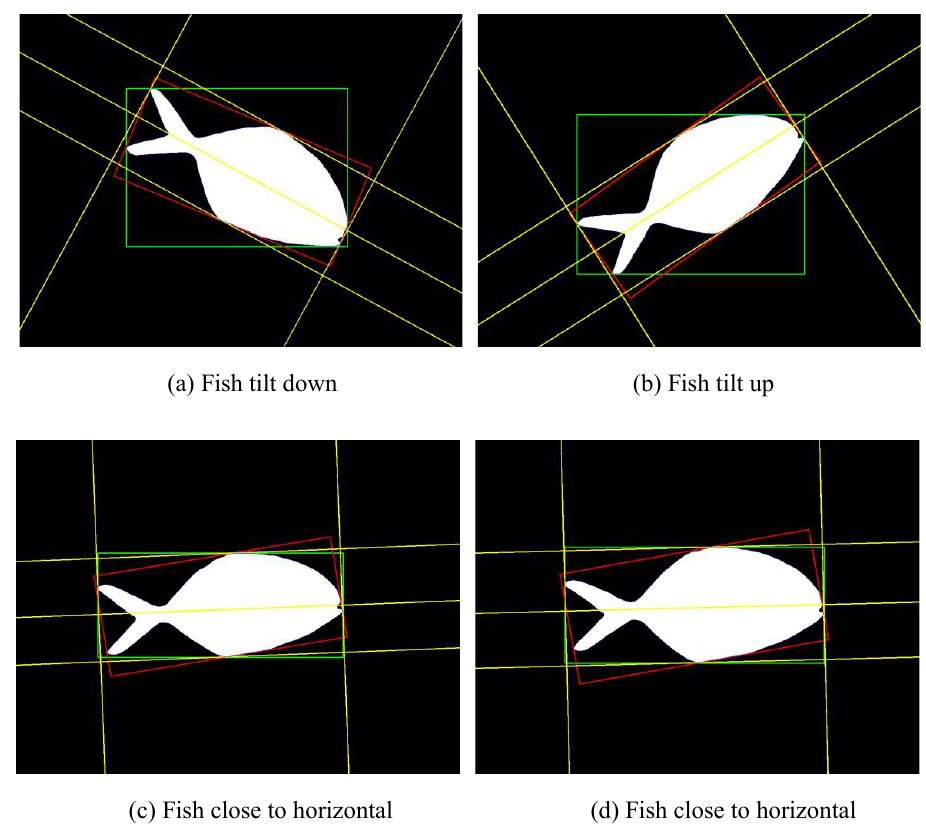
Fig. 13 Comparison of the effects of three measurement schemes. Figure 17. Comparison of the effects of three measurement methods. Circumscribed rectangle is marked with a green line; Smallest circumscribed rectangle is marked with a red line; Line fitting rectangle is marked with a yellow